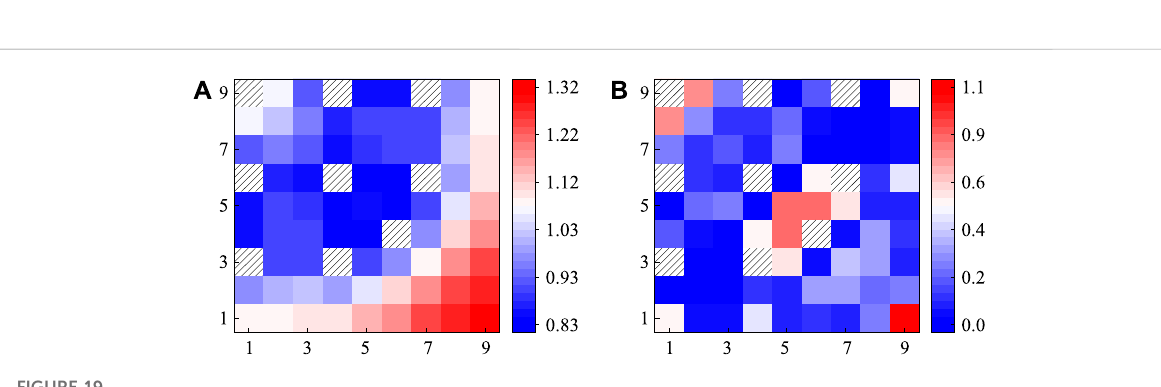
FIGURE 19 Calculation results of pin power of VERA 2H lattice: (A) referenced normalized pin power; (B) absolute value of relative